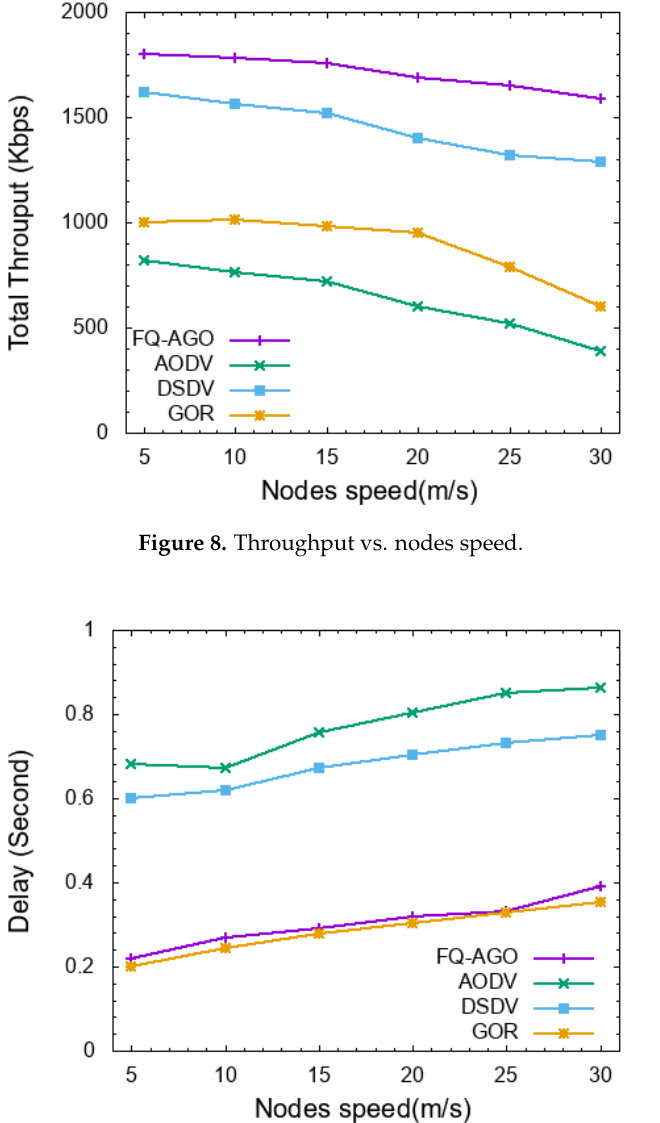
Figure 9. End-to-end delay (seconds) vs. nodes